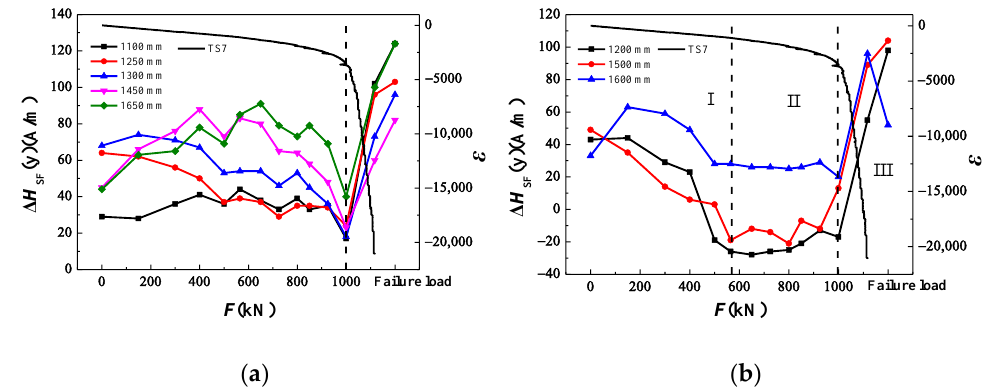
Figure 13. ∆𝐻 SF (y) - F relationship curves of the top flange: ( a ) non-SCZ location; ( b ) SCZ location. Figure 13. ∆ H SF ( y ) - F relationship curves of the top flange: ( a ) non-SCZ location; ( b ) SCZ